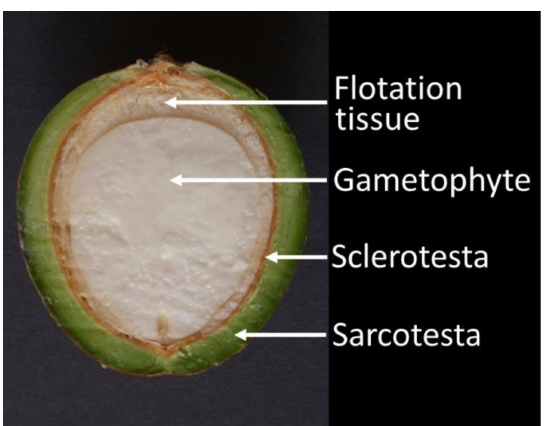
Figure 1. Eleven-month-old Cycas micronesica seed revealing internal